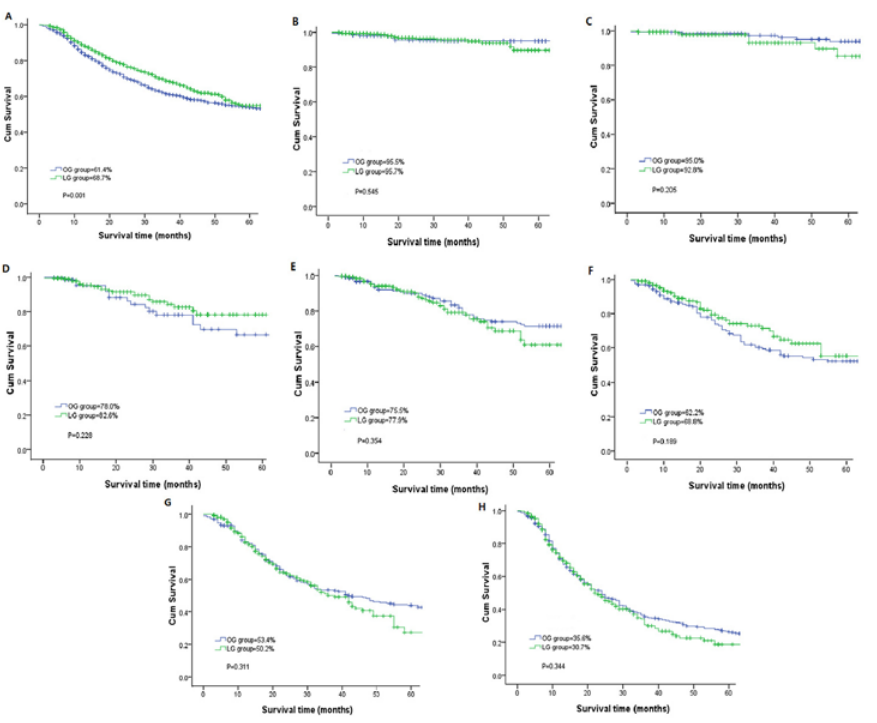
Figure 1. Kaplan-Meier curves for DFS. Kaplan-Meier curves for DFS between the laparoscopic gastrectomy and open gastrectomy groups.